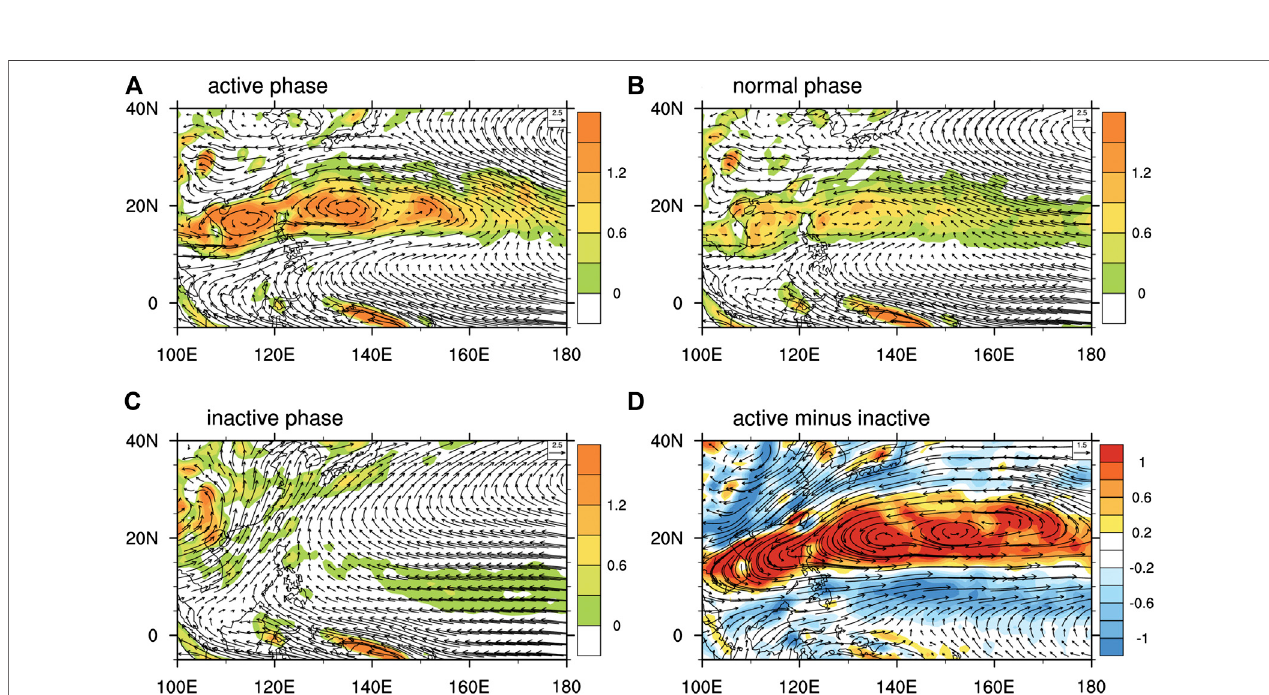
FIGURE 7 | Same as in Figure 2 , but for the 12-year control-run experiment.